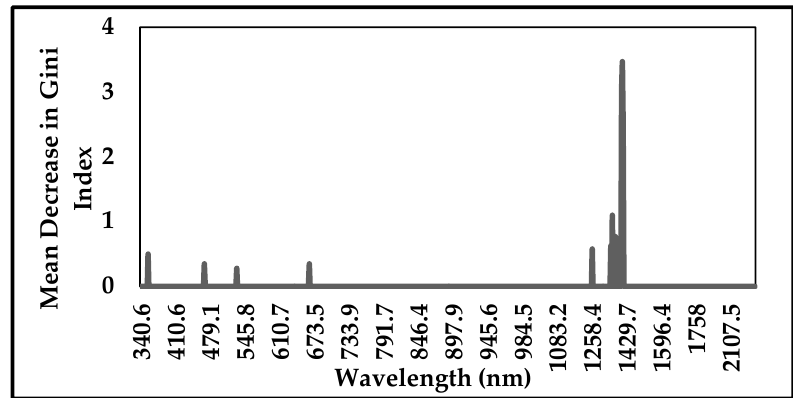
Figure 5. Wavelengths selected by GRRF based on the importance scores as measured by the traditional RF.